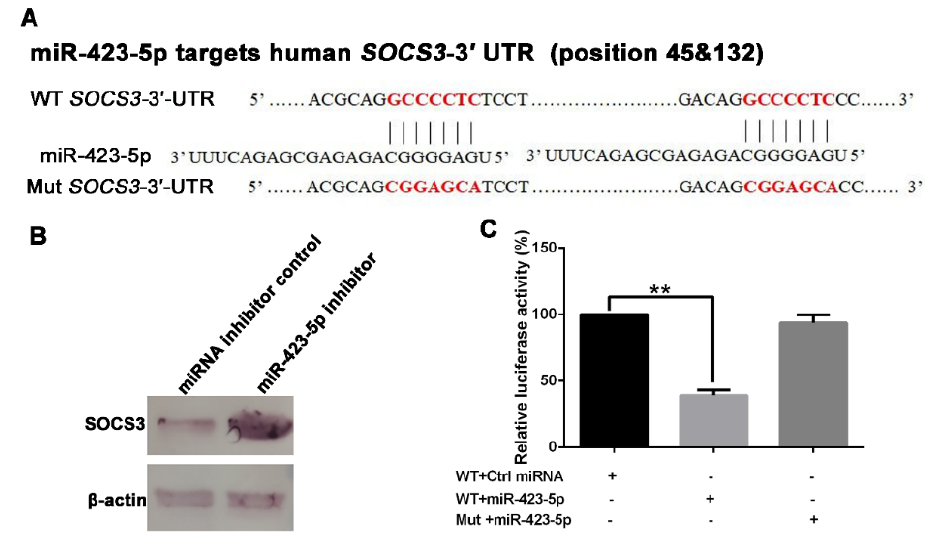
Figure 3. MicroRNA (miR)-423-5p targets the suppressor of cytokine signaling 3 ( SOCS3 ) gene. ( A ) Schematic of miR-423-5p target region of SOCS3 . The RNA sequences of the miR-423-5p wild type (WT) and mutant (Mut) forms are shown. ( B ) MRC-5 cells were transfected with an miRNA-423-5p inhibitor or negative miRNA inhibitor control for 12 h, the culture medium was replaced with fresh media, and the cells were cultured for 48 h. The cells were harvested and the levels of SOCS3 were determined using western blotting. ( C ) MRC-5 cells were co-transfected with the wild-type SOCS3 3 ′ -UTR luciferase vector, mutant SOCS3 -3 ′ UTR, and 100 nmol/L miRNA-423-5p mimic. Relative luciferase activity was measured after 48 h of transfection. The control miRNA mimic was also used as a negative control. Three independent experiments were performed. ** indicates p < 0.01.